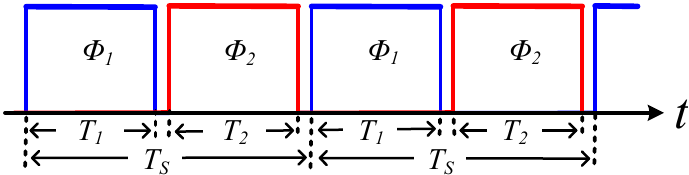
Figure 9. Time control strategy of the voltage balancing system.